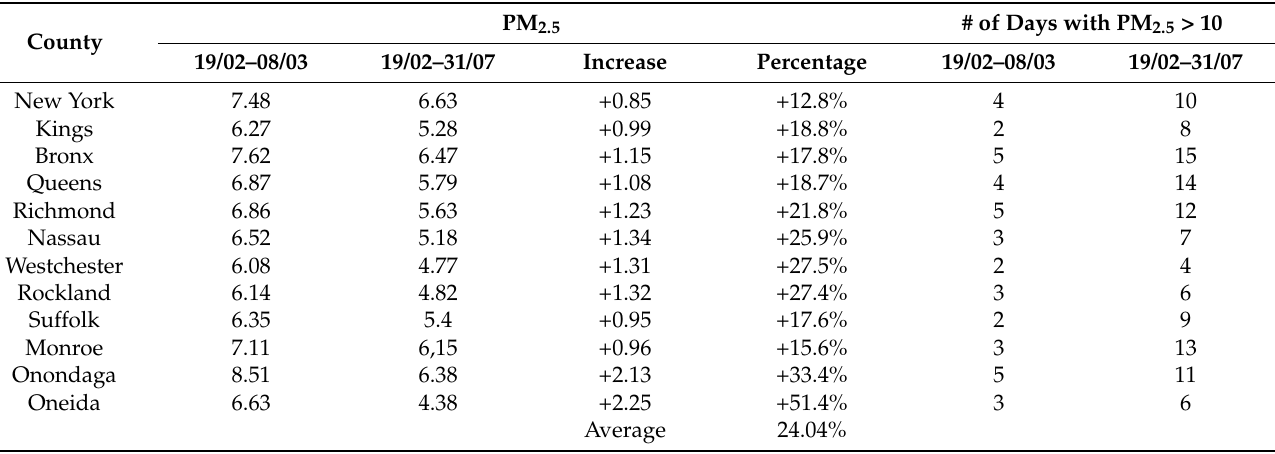
Table 2. The PM 2.5 (short and extended periods) per county, increase, number of days with exceedances (short and extended